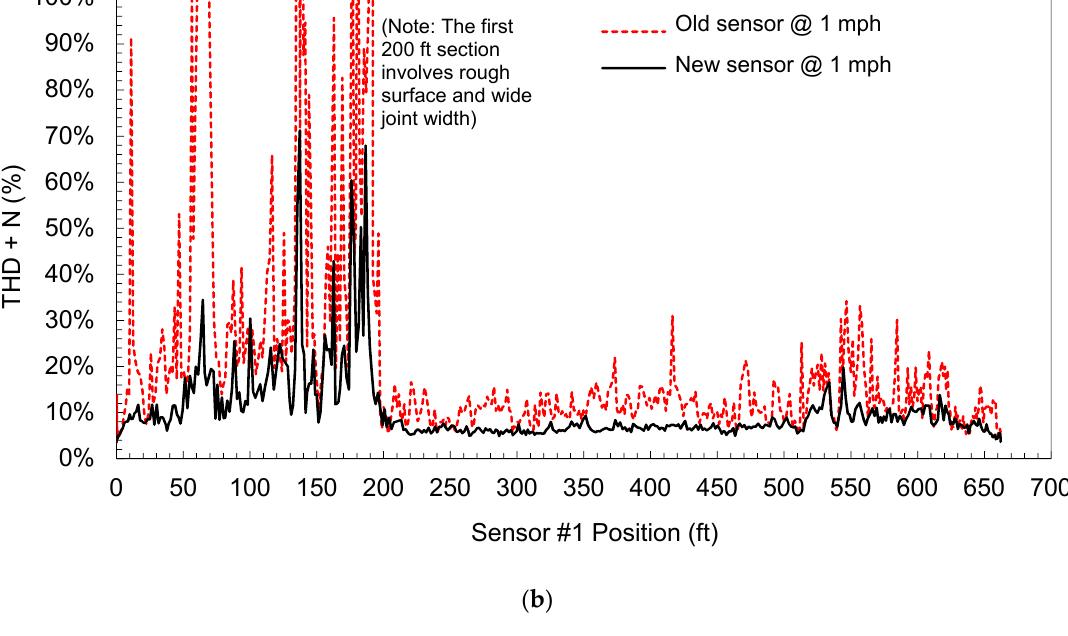
Figure 13. Comparison of noise characteristics of both old and new rolling sensors: ( a ) SINAD profile and ( b ) THD + N profile along a JCP site.